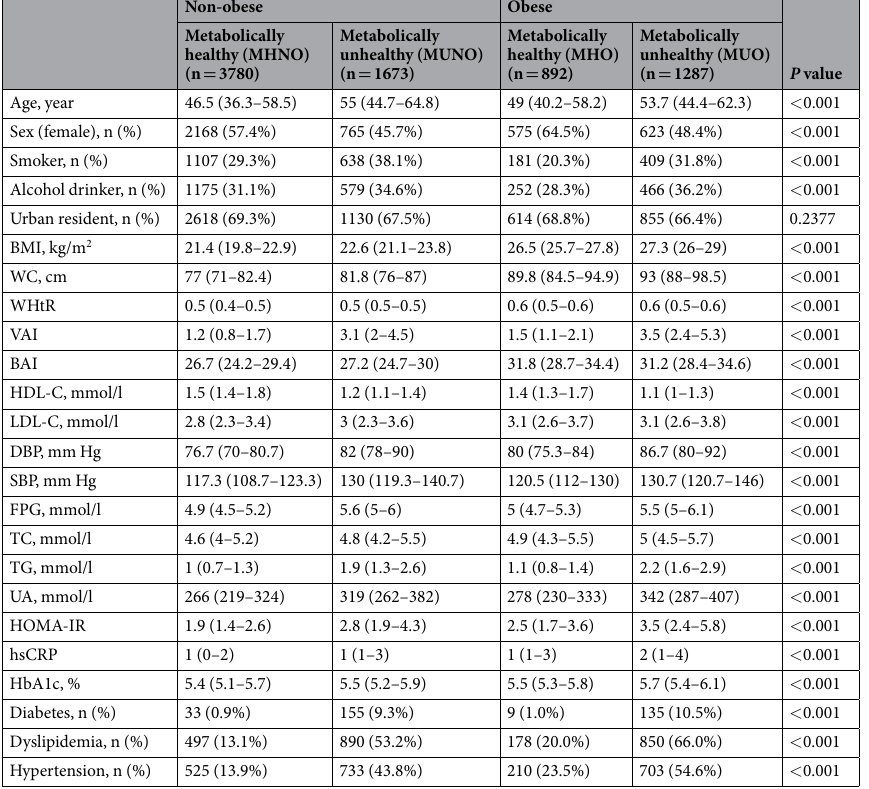
Table 1. Characteristics of subjects according to obesity status (defined by body mass index) and metabolic health status defined by ATP-III criteria. Data are n (%) or median (interquartile range). Abbreviations: ATP- III, the Adult Treatment Panel-III; BMI, body mass index; WC, waist circumference; WHtR, waist-to-height ratio; VAI, visceral adiposity index; BAI, body adiposity index; HDL-C, high-density lipoprotein cholesterol; LDL-C, low-density lipoprotein cholesterol; DBP, diastolic blood pressure; SBP, systolic blood pressure; FPG, fasting plasma glucose; TC, total cholesterol; TG, triglycerides; UA, uric acid; HOMA-IR, homoeostatic model assessment of insulin resistance; hsCRP, high-sensitivity C-reactive